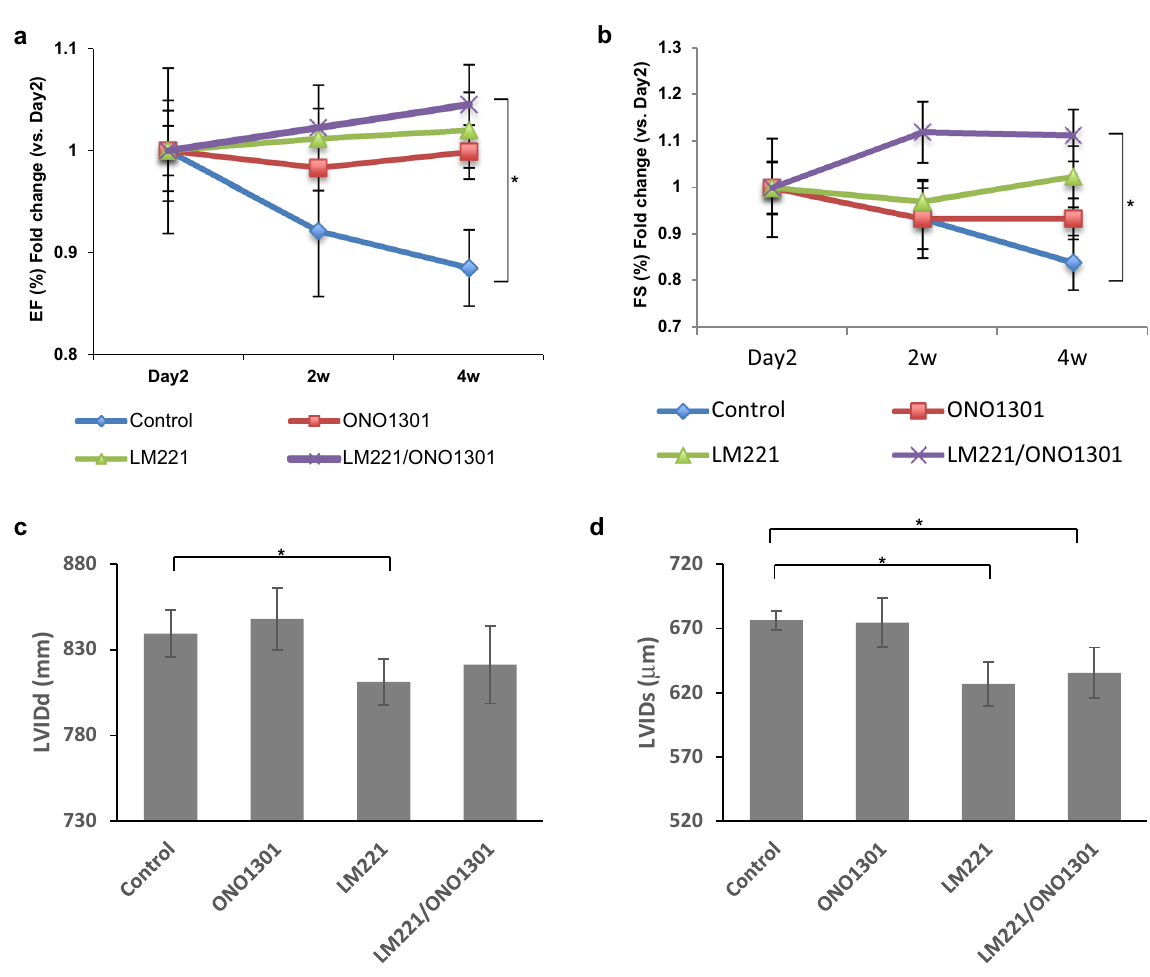
Figure 8. The combined administration of LM221 and ONO1301 improved heart performance. ( a , b ) Line graphs depicting the left ventricle ejection fraction (EF, a ) and fractional shortening (FS, b ) 2 days and 2 and 4 weeks after treatment. ( c , d ) The statistical analysis of the echocardiographic results of the diastolic (LVIDd, c ) and systolic (LVIDs, d ) left ventricular internal diameter 4 weeks after treatment. * p <